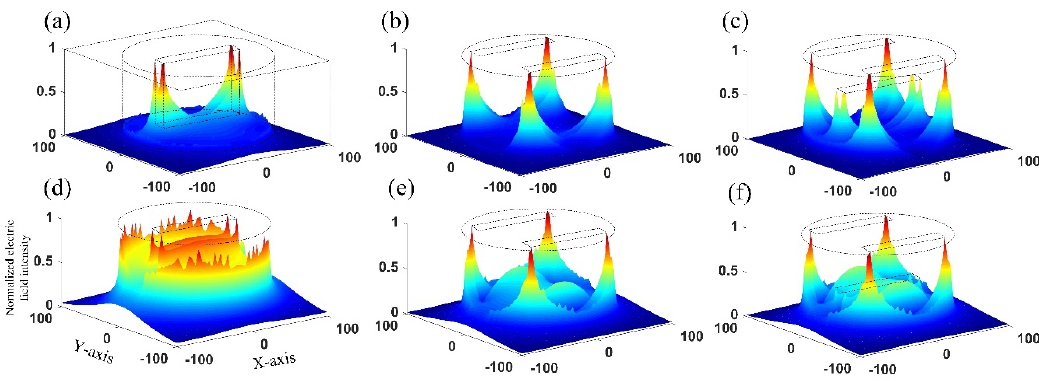
Figure 3. The electric field distribution diagrams in the cases of different number of metal strips. ( a – c ) The polarization direction (0°) of the relative electric field is parallel to the X-axis ; ( d – f ) The polarization direction (90°) of the relative electric field is perpendicular to the X-axis